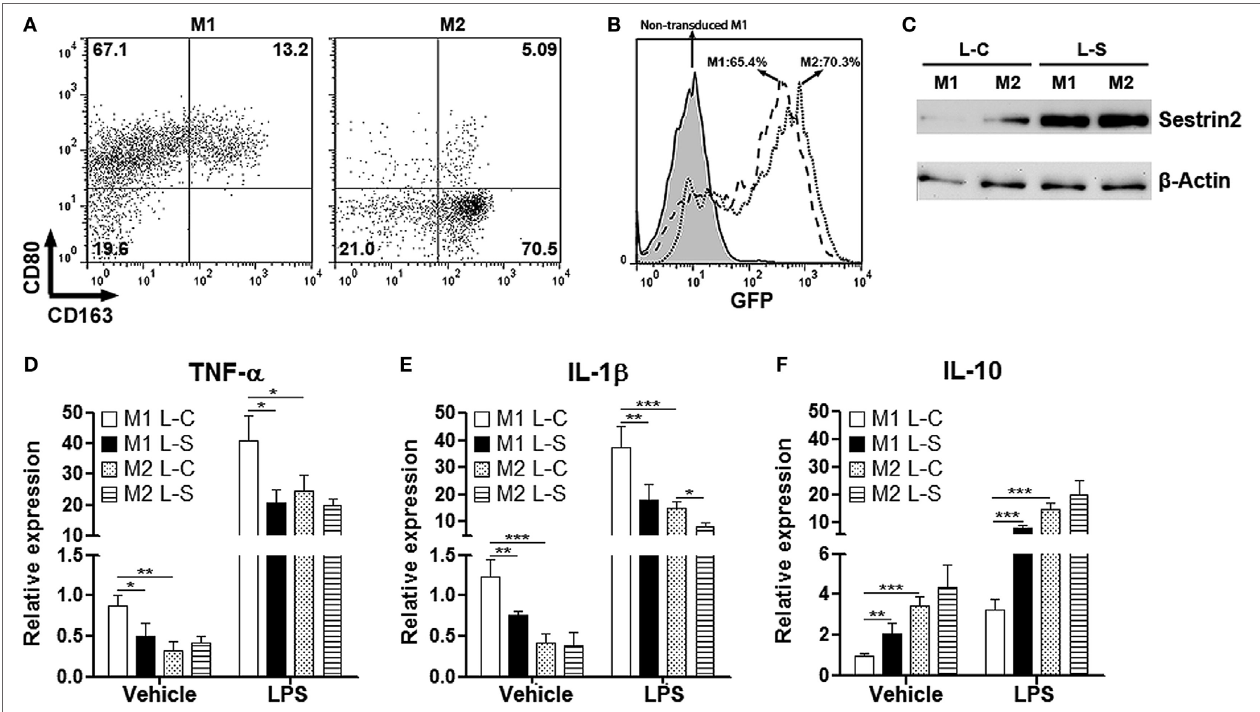
FigUre 2 | Ectopic Sestrin2 expression in M1 macrophages inhibits pro-inflammatory response in vitro . (a) Expression of CD80 and CD163 on in vitro cultured M1 and M2 monocyte-derived macrophages. Numbers in the quadrants are proportions of corresponding subpopulations. This is a representative of two independent experiments. (B) Lentiviral transduction efficiency of cultured macrophages is detected with flow cytometry. Note that here macrophages were not transduced with GFP-free SESN2 lentiviral activation particles. Instead, they were transduced by copGFP lentiviral particles containing GFP sequence. Numbers in the histogram are percentages of GFP + cells. (c) Sestrin2 protein levels in M1 and M2 macrophages after lentiviral transduction. L-C: control lentivirus not inducing Sestrin2 expression. L-S: SESN2 lentiviral activation particles. This is a representative of three independent experiments. (D–F) mRNA abundance of TNF- α , IL-1 β , and IL-10 in lentivirus-transduced M1 and M2 macrophages with or without lipopolysaccharide (LPS) stimulation. M1 L-C: M1 macrophages transduced with control lentivirus. M1 L-S: M1 macrophages transduced with SESN2 lentiviral activation particles. M2 L-C: M2 macrophages transduced with control lentivirus. M2 L-S: M2 macrophages transduced with SESN2 lentiviral activation particles. N = 6 per group. * p < 0.05; ** p < 0.01; *** p <